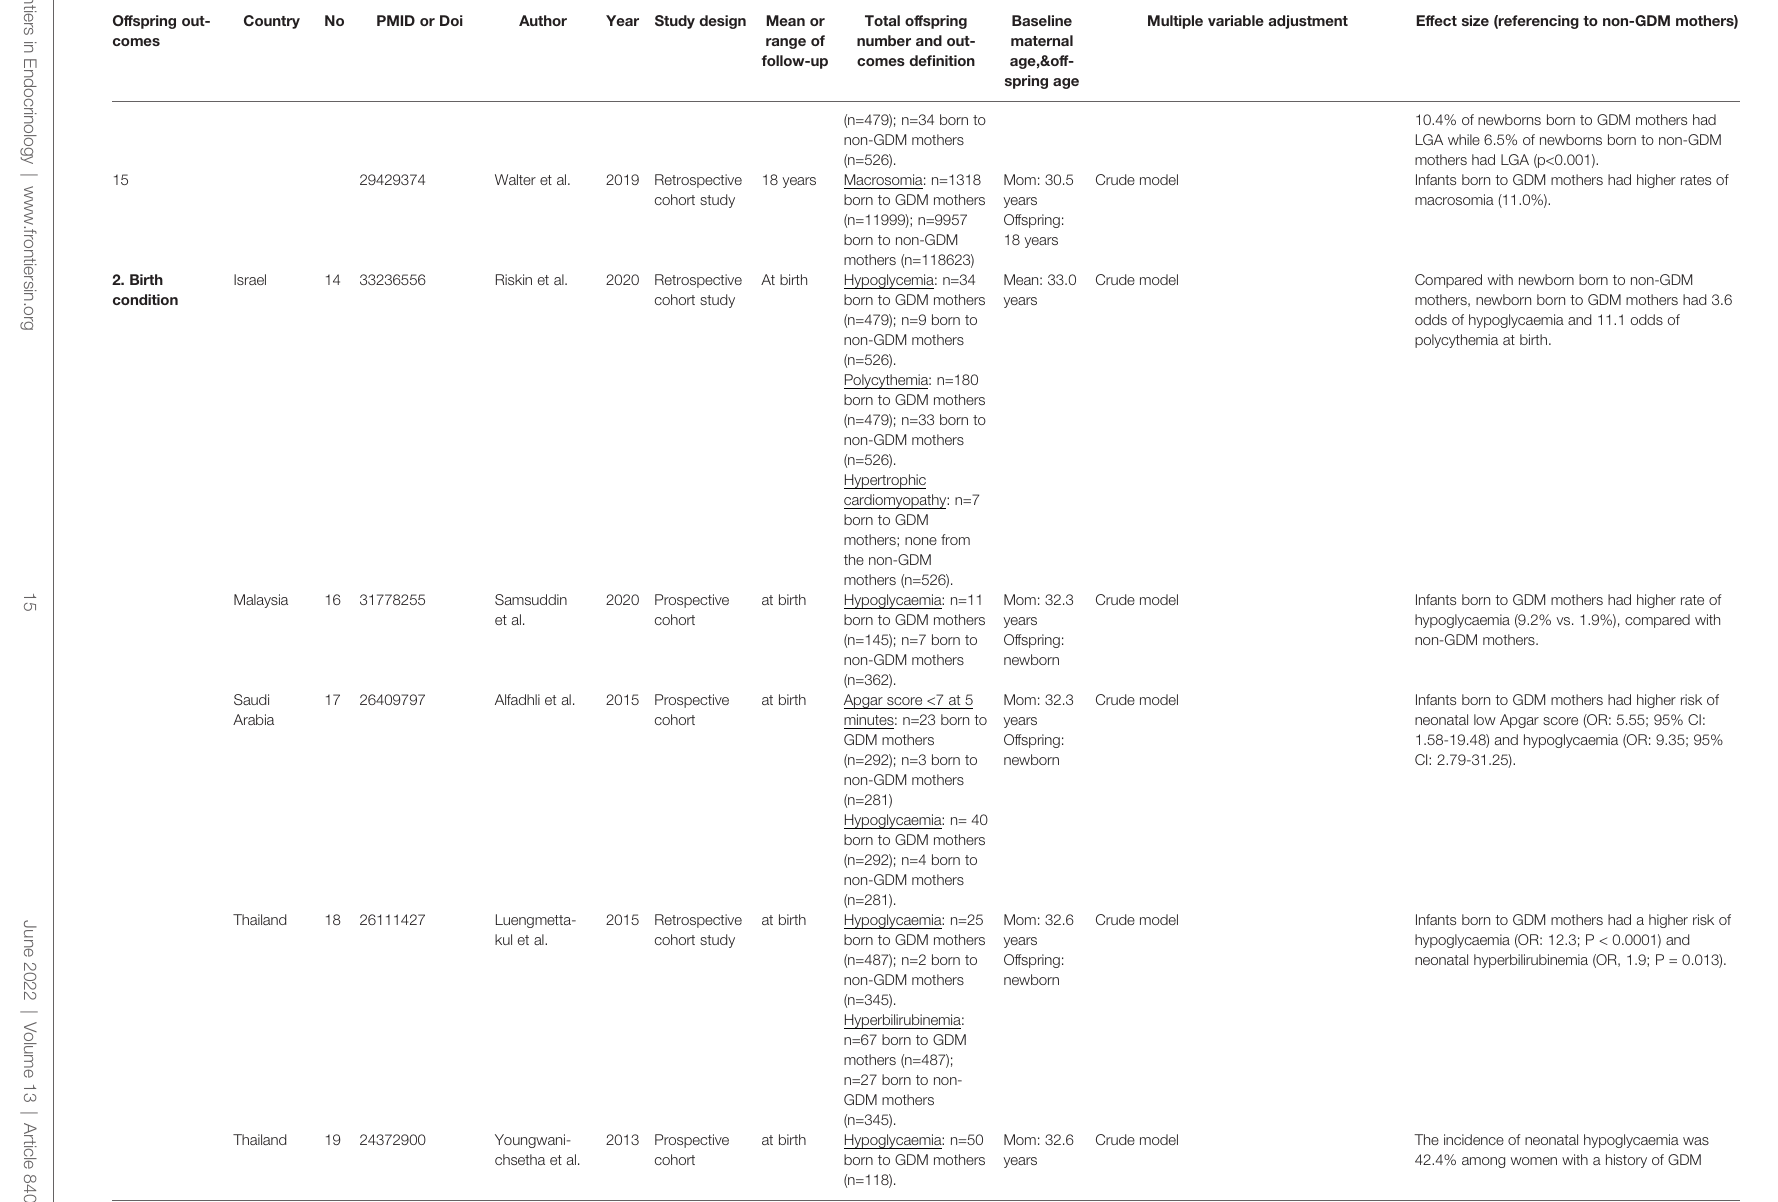
15 Walter et al. 2019 Retrospective